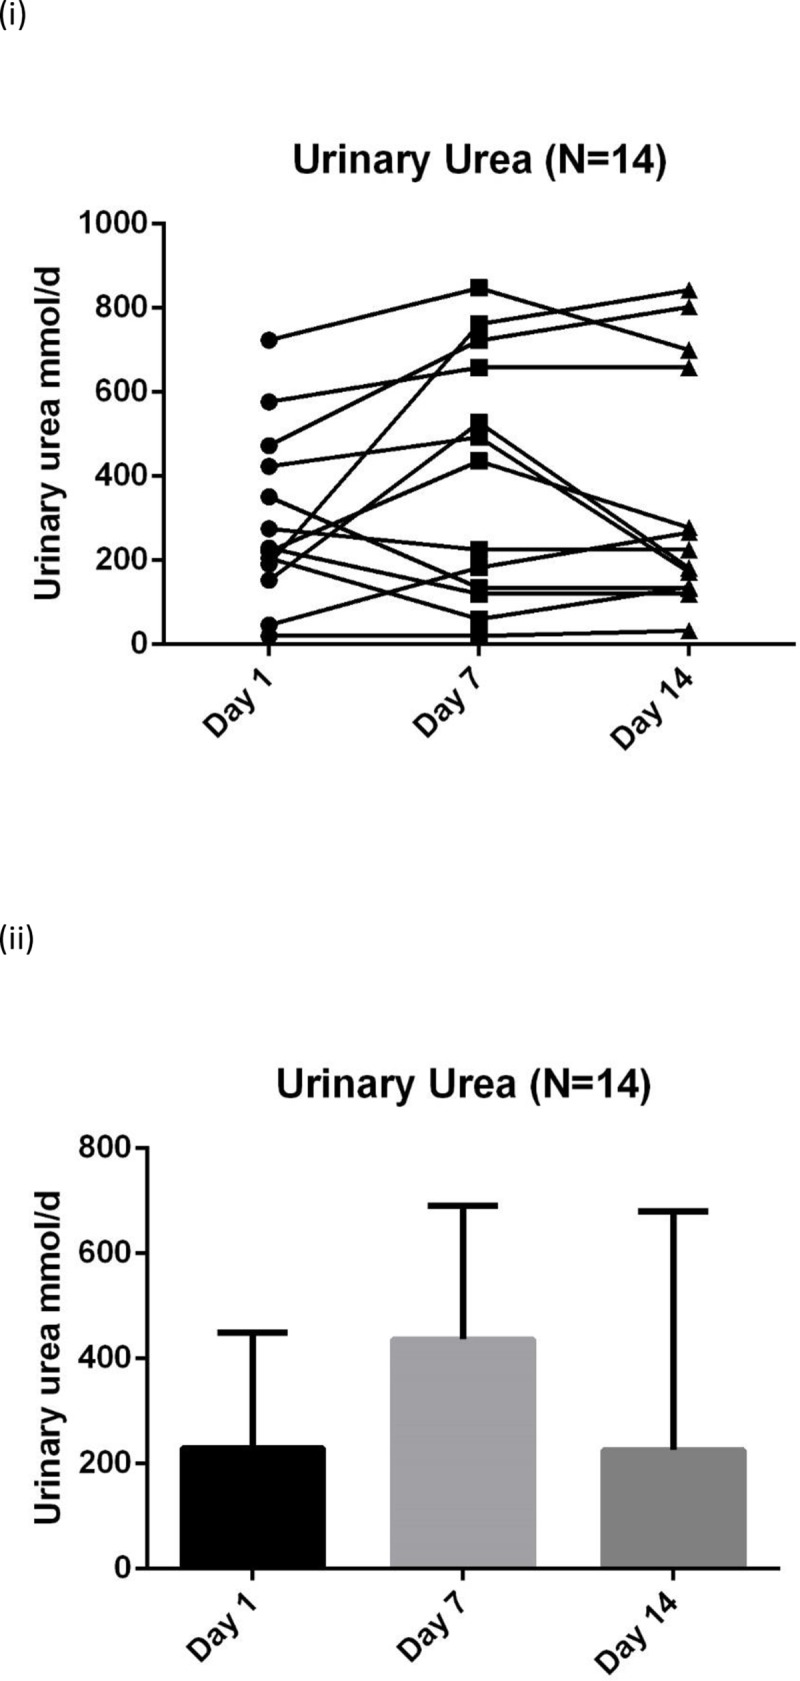
Serial urinary urea (N = 14) measurements in long stay patients: (i) Plots to explore individual variability (ii) Box plots reported with median and IQR.